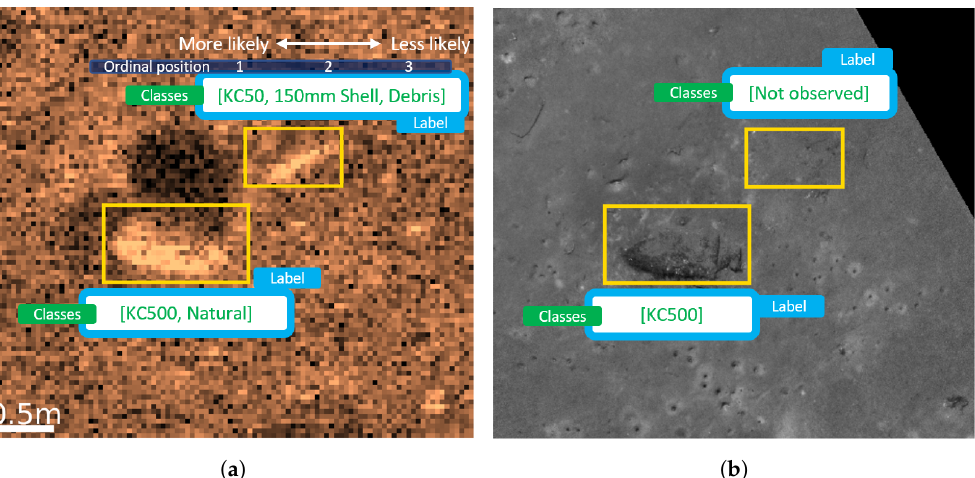
Figure 3. Object labels consist of plausible classes in order of likelihood. Class likelihood is a function of position within the label and label length. ( a ) SAS image with labels, and ( b ) optical image of the same patch of seafloor with superimposed bounding boxes relabelled. Motivation for the classes chosen is given in Section